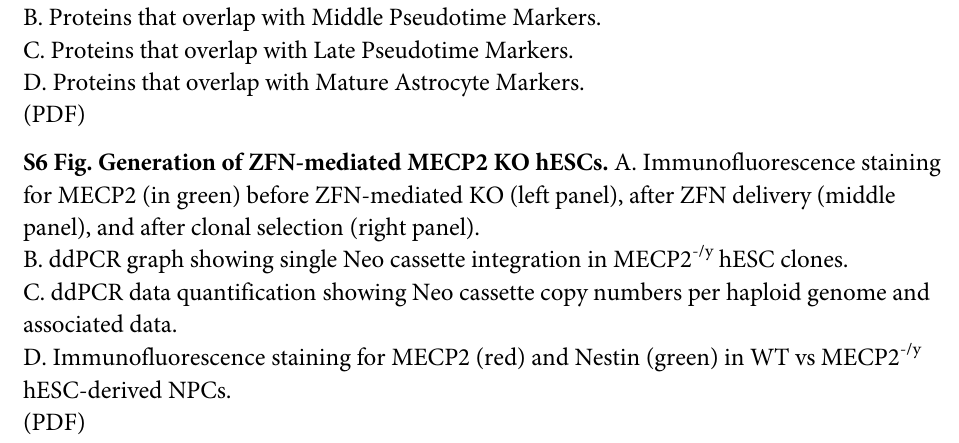
S5 Fig. Many perturbed proteins are astrocyte markers previously profiled in human corti- cal spheroid cultures derived from iPSCs[35]. A. Proteins that overlap with Early Pseudo- time Markers.